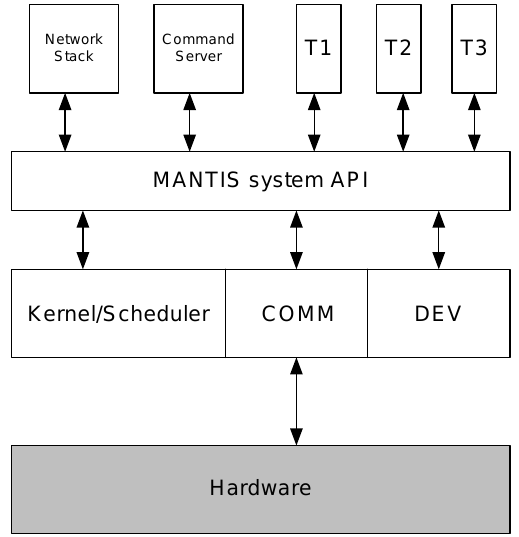
Figure 4. MANTIS OS Architecture. Kernel Scheduler, COMM, DEV, MANTIS System API, Network Stack, and Command Server comprises